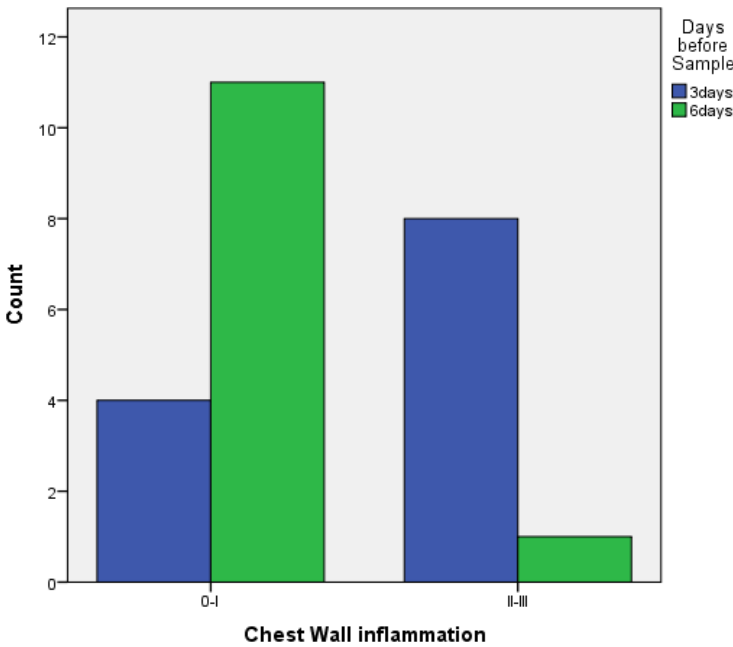
Figure 8. Parietal pleura inflammation at 3 vs. 6 days of PRP and talc combined.